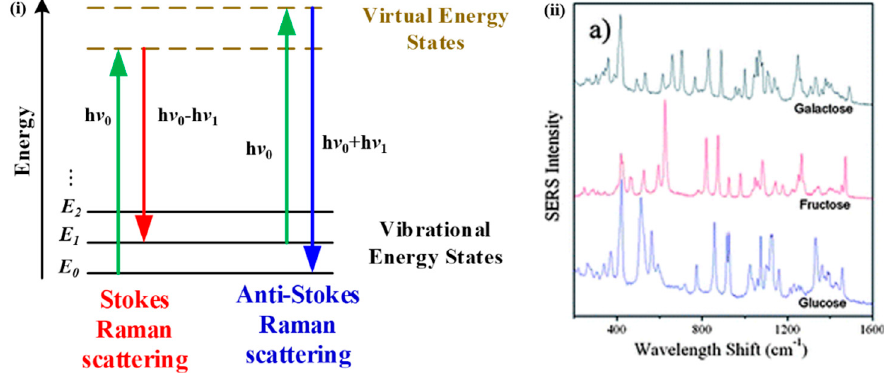
Figure 7. ( i ) An energy diagram of Raman scatterings. ( ii ) Examples of Raman spectra of different sugars. Reprinted with permission from [108]. SERS, surface-enhanced Raman spectroscopy.